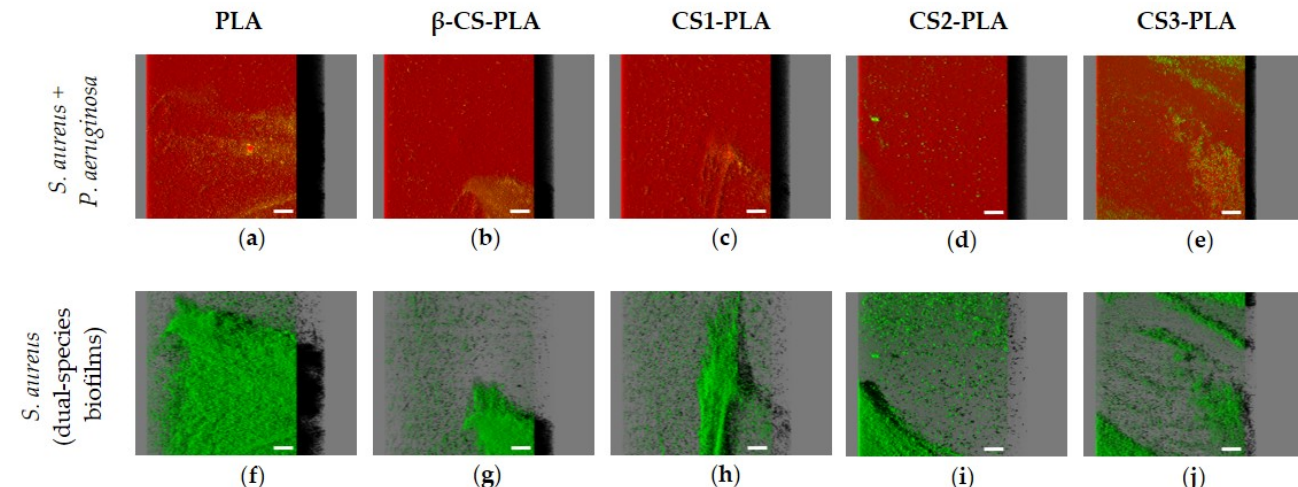
Figure 5. Dual-species biofilms of S. aureus and P. aeruginosa on PLA and CS-coated PLA surfaces. These representative images were obtained using IMARIS software and show an aerial view of biofilm structures, with the shadow on the right representing the vertical projection of the biofilm. The first row ( a – e ) presents the combination of red and green filters ( S. aureus + P. aeruginosa ), while the second row ( f – j ) corresponds only to the green filter ( S. aureus ). Scale bars are 50 µ